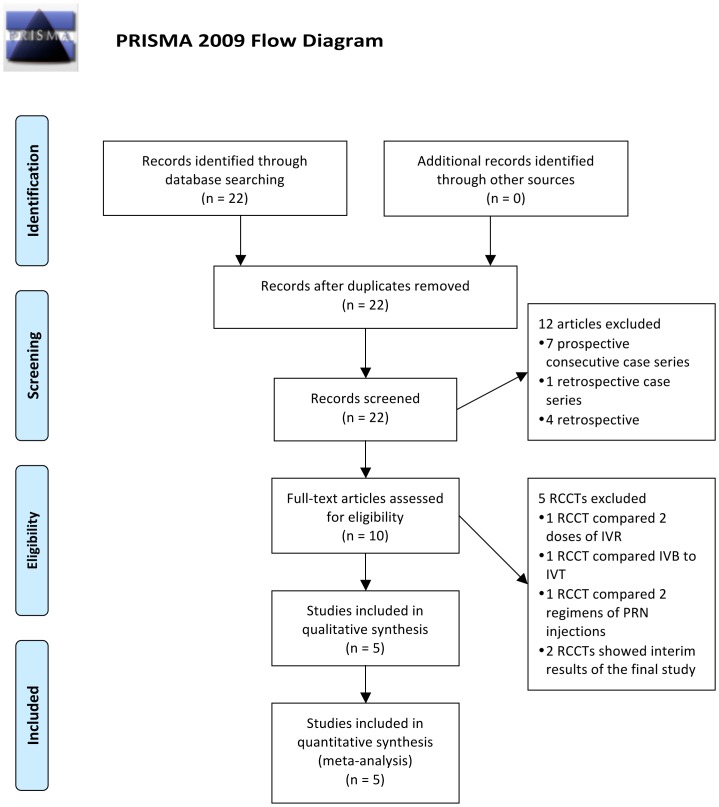
Flow chart of search strategy and study selection.RCCT: Randomize Case Controlled Trial, IVR: IntraViteal Ranibizumab, IVB: IntraViteal Bevacizumab, IVT: IntraViteal Triamcinolone acetonide (IVT), PRN: Pro Re Nata.